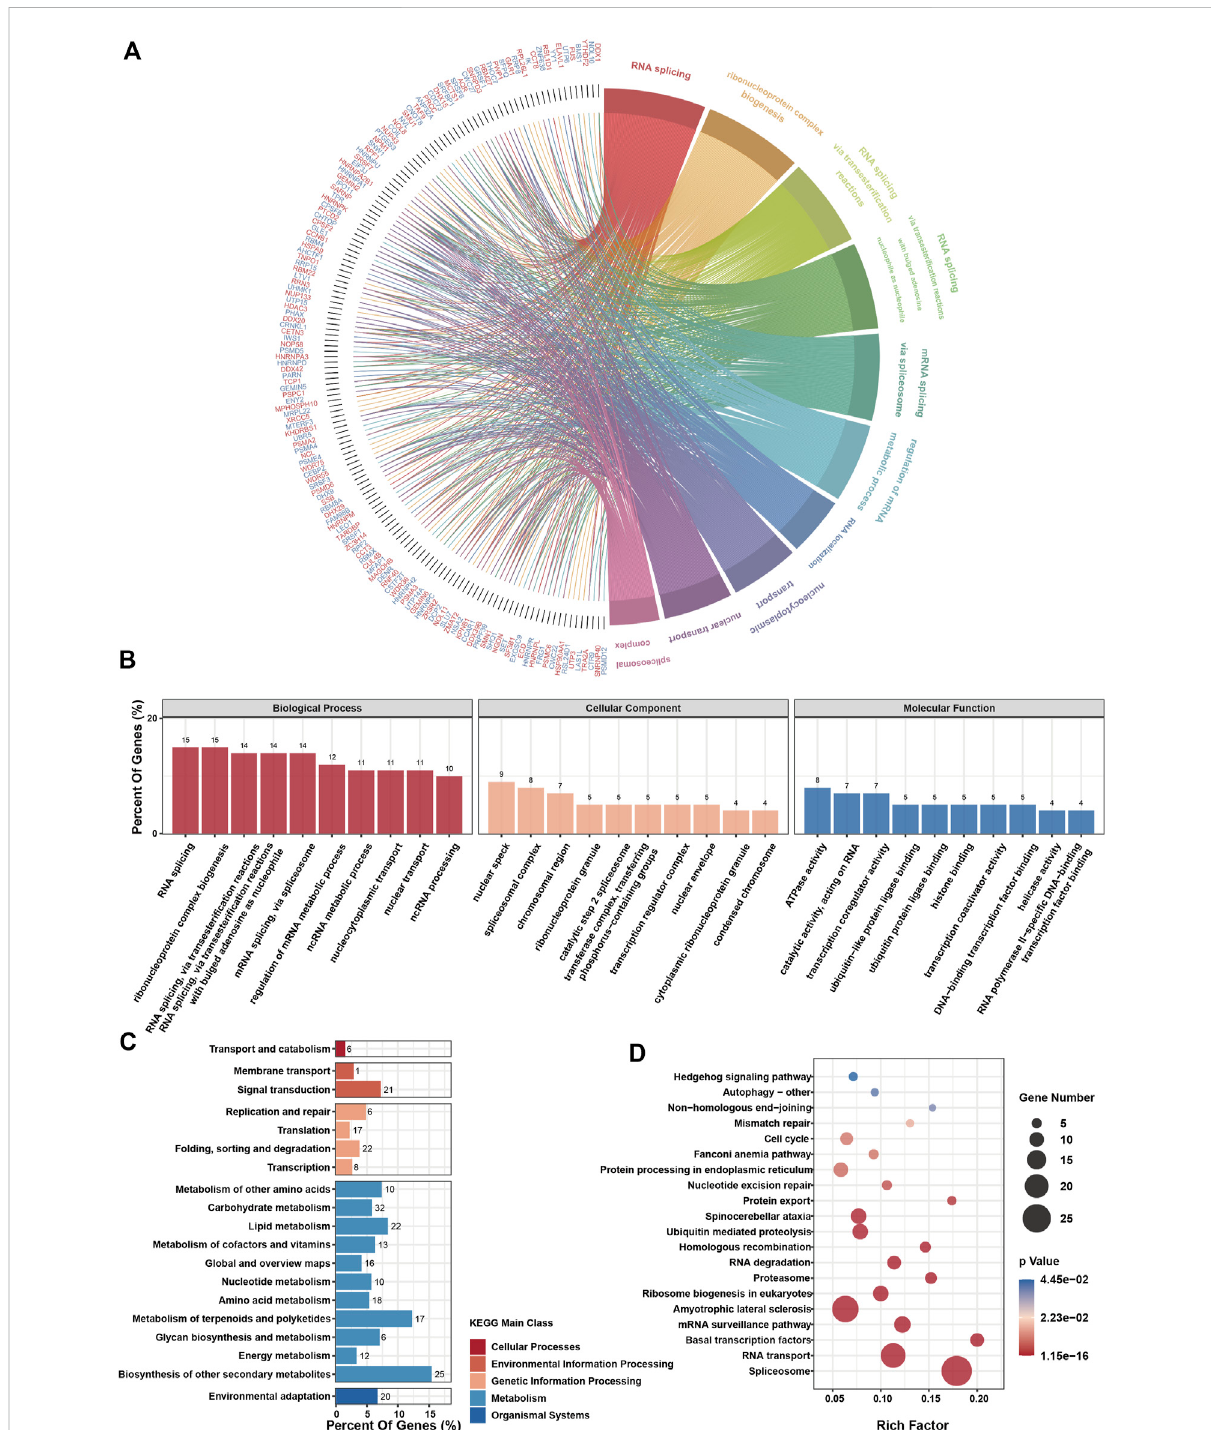
RIOK2-related genes enrichment analysis in tumor tissues. (A) The chord diagram depicts gene enrichment in the top ten biological processes processed by the GO enrichment analysis. (B) GO enrichment analysis of the top 500 RIOK2 expression-related genes in various types of tumor tissues. The functions of these genes were classi fi ed into three categories: biological processes, cellular components, and molecular functions. The ordinate represents thepercentageofgenes enriched for thisfunction. (C) KEGGenrichmentanalysisofthetop 500RIOK2 expression-related genes in various types of tumor tissues. The functions of these genes enriched by KEGG are classi fi ed into fi ve main classes: cellular processes, environmental information processing, genetic information processing, metabolism, and organismal systems. The ordinate represents the percentage of genes enriched in the function. (D) The ScatterPlot shows the KEGG enrichment pathways, which have signi fi cantly rich factors ( p <